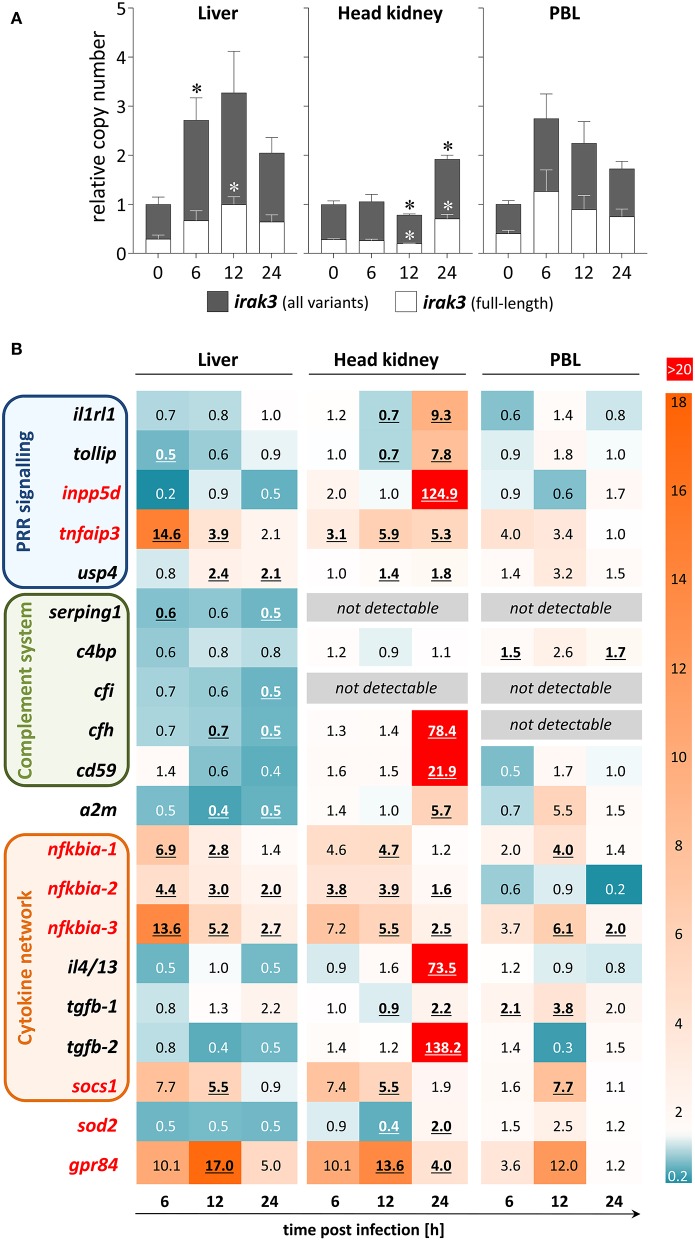
Expression profile of regulatory immune genes during A.-salmonicida infection of rainbow trout. (A) We used discriminating primer pairs to determine the abundance of all irak3 variants in trout (filled columns) and the proportion of the full-length irak3 transcripts (open columns) in the liver (left panel), head kidney (central), and PBLs (right) of four individuals at the various time points after infection relative to uninfected fish (0 h; set as 1.0). Significant copy-number changes (p < 0.05) are marked with an asterisk (*); error bars indicate SEM. (B) The HeatMap illustrates the averaged fold-change values (according to the legend on the right) of the mRNA concentrations measured in the liver (left panel), head kidney (central), and PBLs (right) at the time points after infection indicated below the scheme relative to controls (set as 1.0). The quantified transcripts are listed as gene symbols on the left and categorized according to their affiliation to immune processes; orthologs whose expression is IRAK3-dependent in mammals according to Zhou et al. (5) are marked in red. Significant copy-number changes (p < 0.05) are underlined. All expression values were normalized against the geometric means of the reference genes eef1a1 and rps5 as evaluated with the qBase+ software.